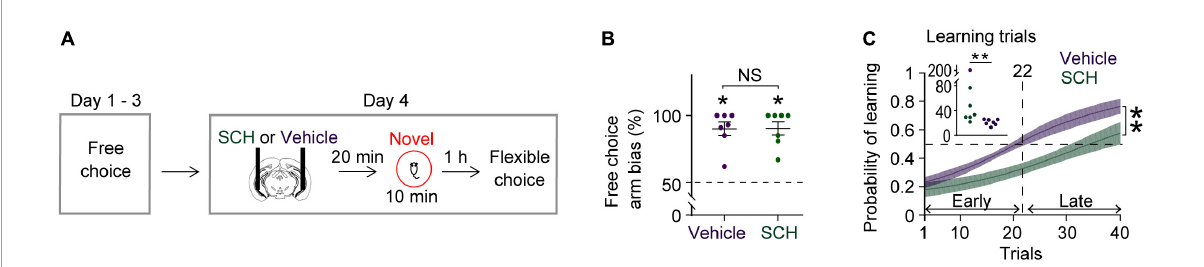
FIGURE3 Blocking D1Rs in the vHPC prevents novelty-enhanced learning. (A) Experimental design. (B) Mice established an arm bias after 3 days of free choice sessions, before the administration of vehicle ( n = 7) or SCH ( n = 7) on day 4 (Wilcoxon signed-rank test, vehicle, P = 0.02; SCH, P = 0.02; vehicle vs. SCH, Mann Whitney test, P = 0.9). (C) Mice treated with SCH underperformed during flexible choice training compared with those treated with vehicle [Two-way RM ANOVA test, F ( 1 , 12 ) = 13.25, P = 0.003]. The average learning trials were 22 (Vehicle) and 63 (SCH) (Mann–Whitney test, P = 0.004). Insets, learning trial of each mouse. * P < 0.05, ** P < 0.005. Data are represented as mean ± SEM. (C) Adopted from Park et al.